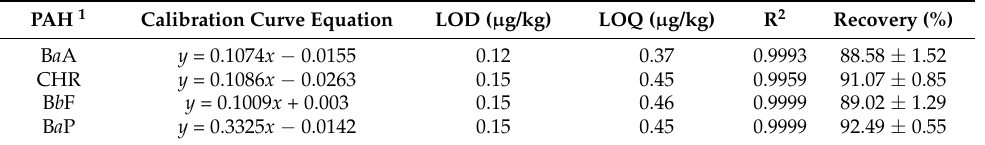
Table 1. Calibration curve equations, limit of detection (LOD), limit of quantification (LOQ), linearity (R 2 ), and % recovery for validation of polycyclic aromatic hydrocarbons (PAHs). PAH